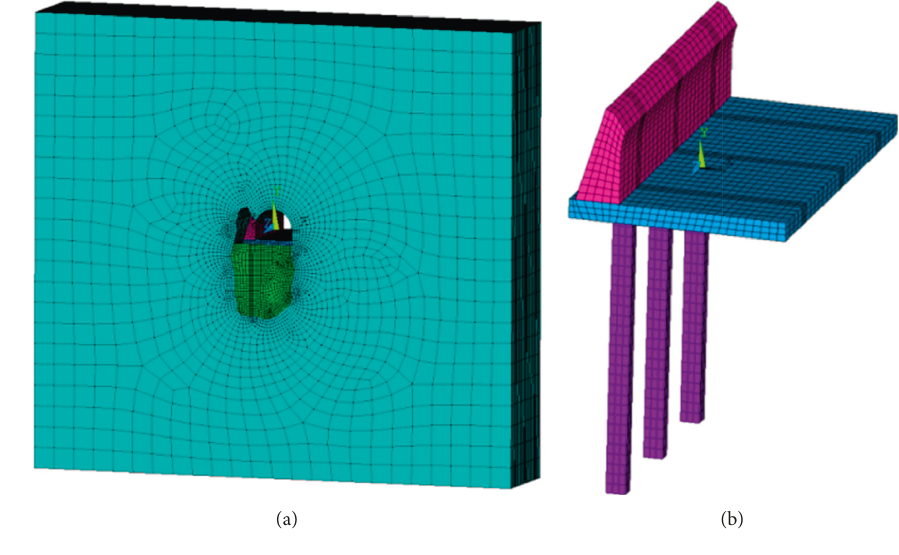
Figure 3: Numerical analysis Table 1: Mechanical parameters of surrounding rock and artificial structure material.